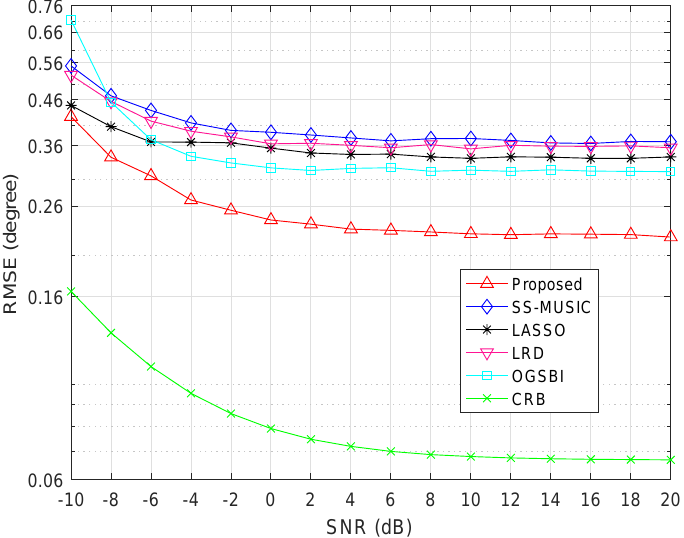
Figure 4. Root-mean-square error (RMSE) as a function of signal-to-noise ratio (SNR) with T =